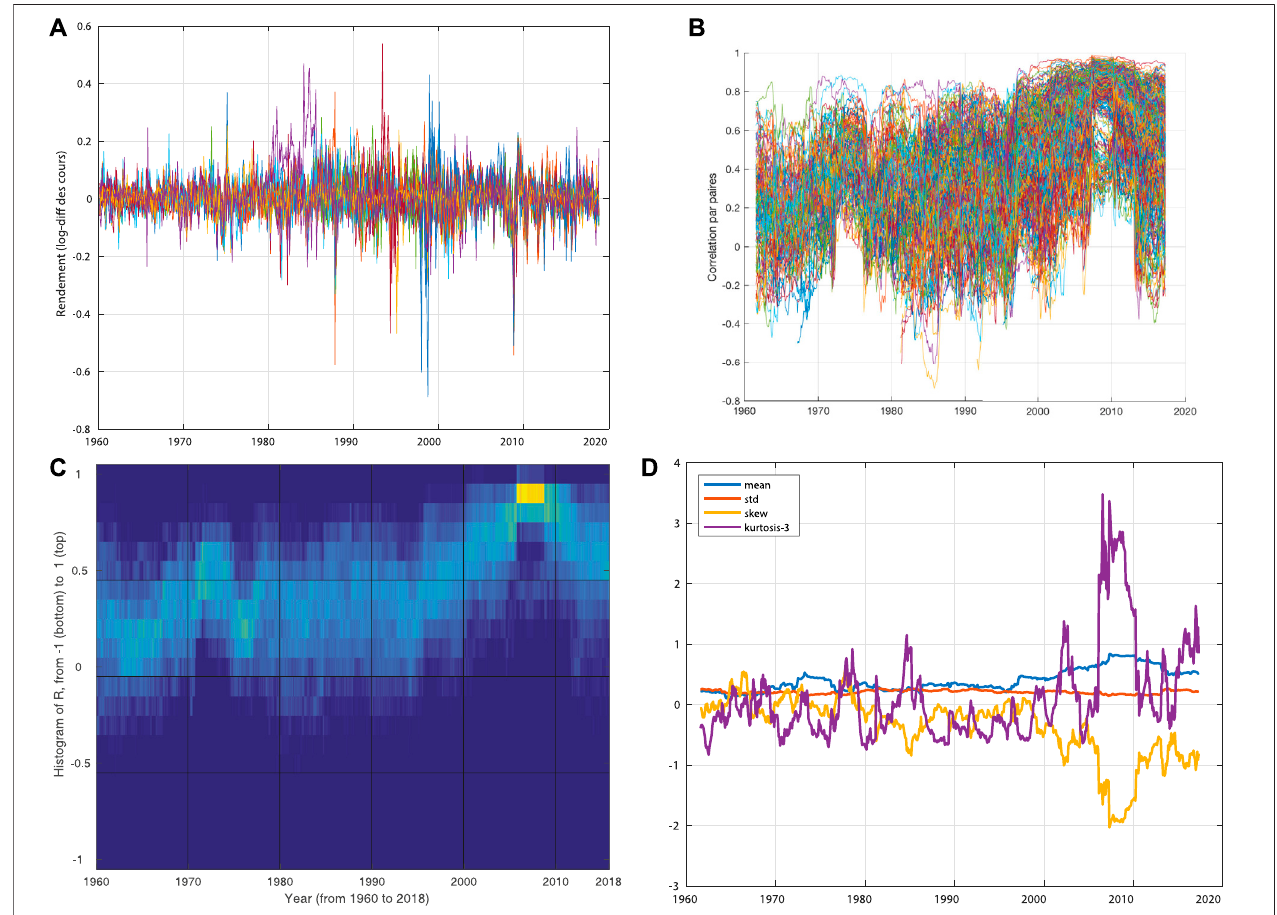
FIGURE 3 | Visualisation of (A) the corrected and log-differentiated series (log returns), (B) the pairwise correlations, (C) the histogram over time of these correlations and (D) the indicators mean μ , standard deviation σ , skewness s , and kurtosis γ , at each t .s.